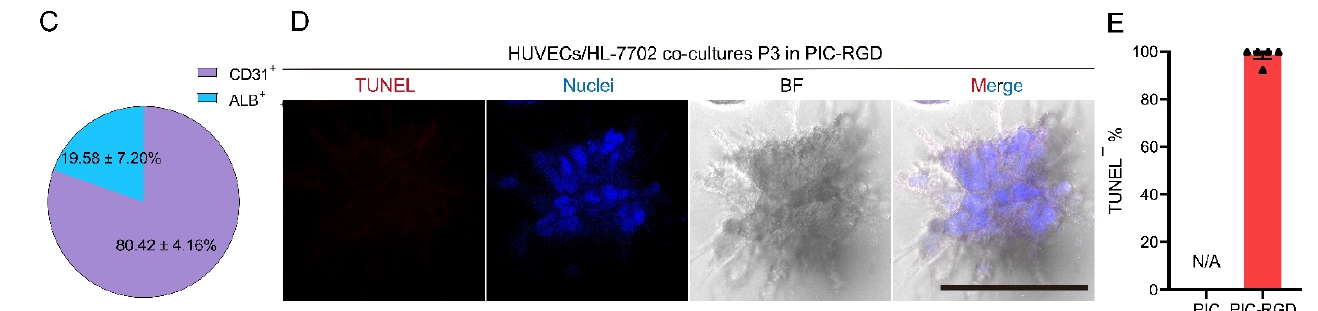
Figure 5. Co-culture of HUVECs with HL-7702 in PIC hydrogels. ( A ) HUVECs and HL-7702 cells were encapsulated in PIC-RGD and went through 7 days of culture and 3 rounds of passaging in PIC-RGD (scale bar = 200 µ m). The enlarged image represents the dashed area in A, and black arrows show the representative structure of co-culture that differs from the culture of HUVECs alone (scale bar = 50 µ m). ( B ) Fluorescence staining of co-culture in PIC-RGD shows good maintenance of cellular properties after 3 rounds of passaging in PIC-RGD. ALB: in red, HL-7702 maker; CD31: in green, EC maker; phalloidin: in yellow, stains F-actin, and Hoechst 33342: in blue, stains cell nuclei (scale bar = 50 µ m). ( C ) Percentage of ALB and CD31 positive cells in four fields of vision. ( D ) TUNEL assay (red) with Hoechst 33342 staining (blue, cell nuclei) and bright field image of P3 co-culture of HUVECs and HL-7702 after 7 days in culture in PIC-RGD show few apoptotic cells in co-cultures (scale bar = 200 µ m). ( E ) Percentage of TUNEL negative cells per field of vision. For all samples, the PIC-RGD concentration c = 1 mg mL − 1 and the initial cell density is 200,000 cells mL − 1 for mixed cells, and 100,000 cells mL − 1 for each kind of cell, respectively. N/A represents not applicable data, since plain PIC does not support HUVECs/HL-7702 co-culture.